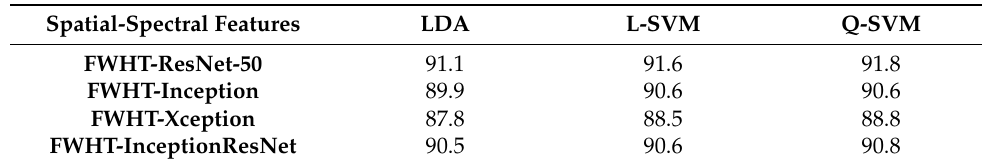
Table 2. The accuracy (%) attained using spatial-spectral features obtained after applying FWHT on the spatial features extracted from the four CNNs of DIAROP diagnostic tool.